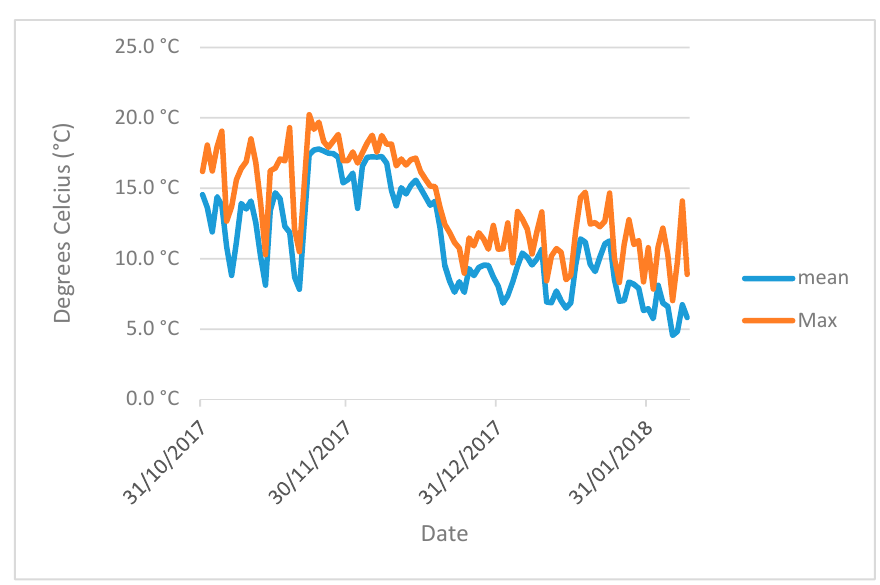
Figure A2. Temperature during growth of cover crops (°C).